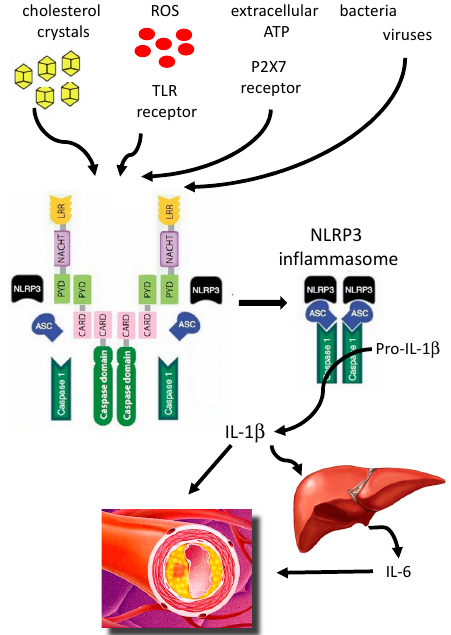
Figure 2. Different agents trigger (after a priming process) the activation of the NLRP3 inflammasome-IL-1 β pathway to promote atherosclerosis. ASC, apoptosis-associated speck-like protein containing a caspase recruitment; ATP, adenosine triphosphate; CARD, caspase recruitment domain–containing protein; IL-1 β , interleukin IL-1 β ; IL-6, interleukin 6; LRR, leucine-rich repeats; ROS, reactive oxygen radicals; TLR, Toll-like receptor.